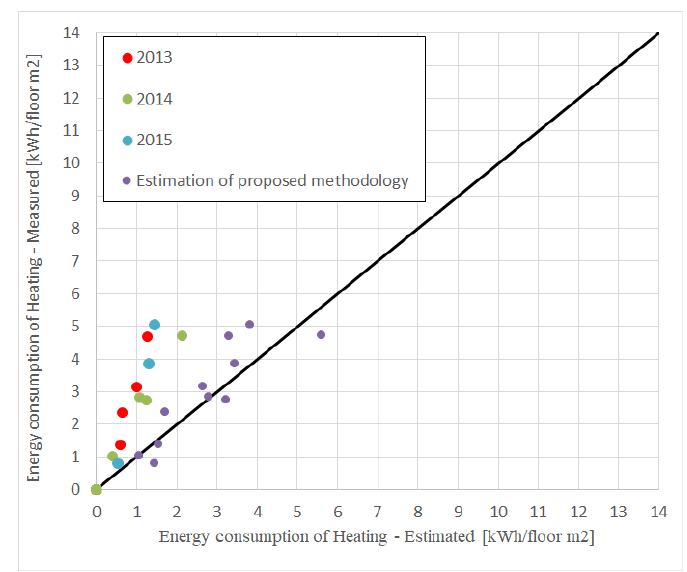
Figure 11. Comparison of tool without corrections (red, green and blue in di ff erent years) and with corrections using the measured energy consumption.